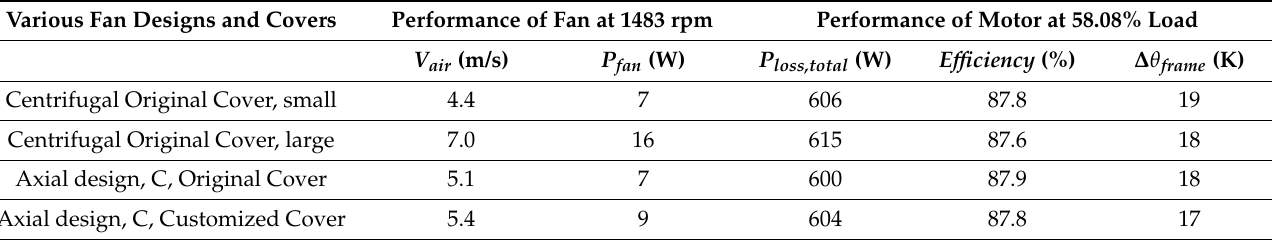
Table 3. Part-load experimental results with four different cooling fan systems [30].